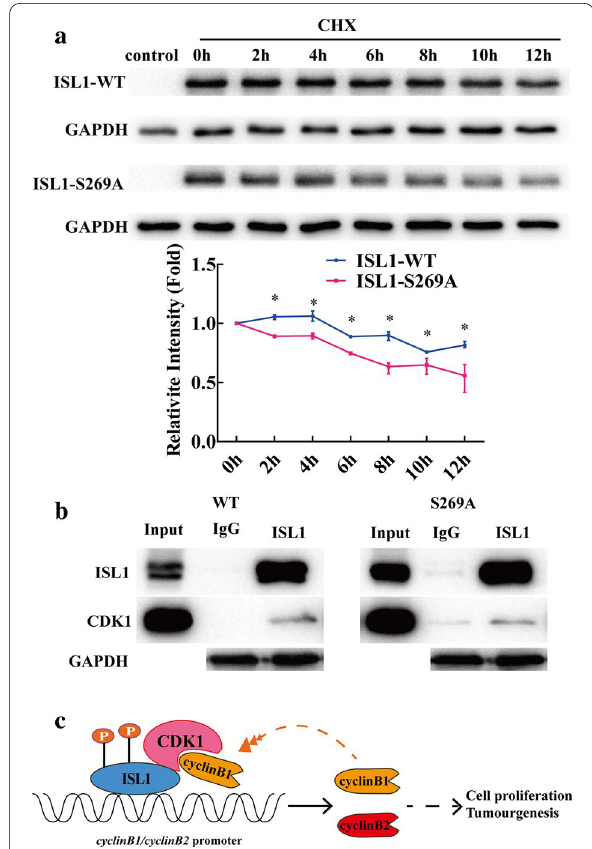
Fig. 6 Phosphorylation of ISL1 increases self-stability but does not increase its interaction with CDK1. a NIH3T3 cells were transfected with wild-type ISL1 or ISL1-S269A plasmids. After 48 h, cells were treated with CHX (100 µg/ml) for 12 h. Whole cell extracts were harvested for western blotting. b Co-IP assays were performed in NIH3T3 cells to detect the interaction between ISL1 (wild-type or mutants) and CDK1. GAPDH served as a loading and negative control. c Schematic representation of positive feedback regulation by the ISL1-CDK1/cyclin B1/2 complex in GC. Full arrow: confirmed; broken arrow: to be